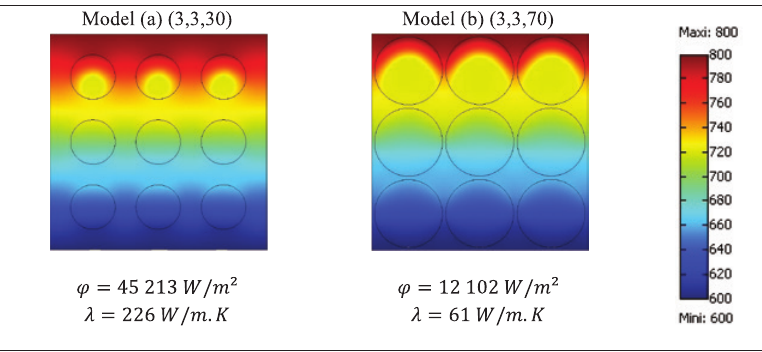
Fig. 4: Influence of the increase of the PCM tube’s radius on the heat transfer and thermal